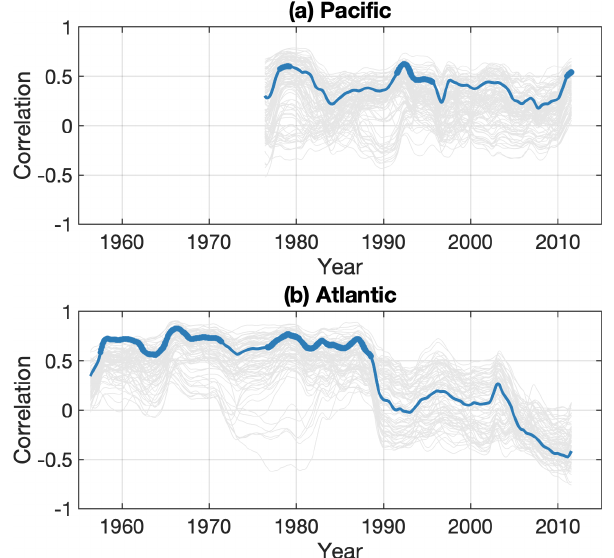
Figure 4. Moving correlation analysis between tide gauge records with a running window of 15 years. Each individual grey line ren- ders the moving correlation between two records. The x axis rep- resents the centre of the moving window. (a) Cross-correlation be- tween the Oyashio group and west of the Kii group (grey lines). (b) Cross-correlation between gauges on either side of Cape Hat- teras, the separation point of the Gulf Stream (again, grey lines). In each panel, the solid blue line is the moving correlation between the group average of sea-level anomalies. Significant correlations above the 95% level are indicated by a thicker blue